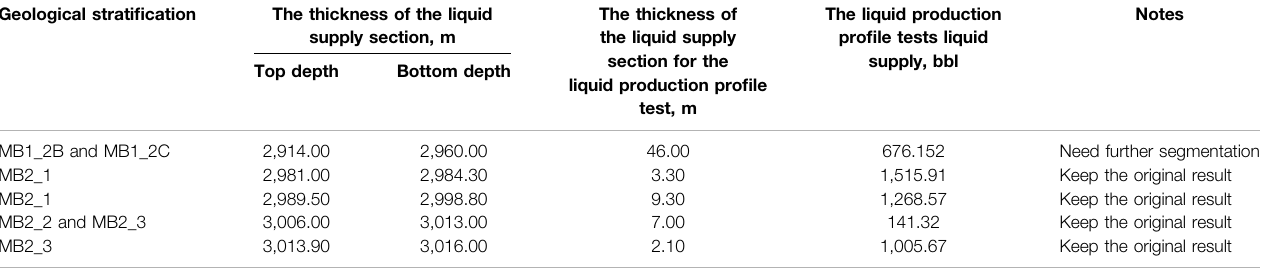
TABLE 2 | The result of the production pro fi le of P1.